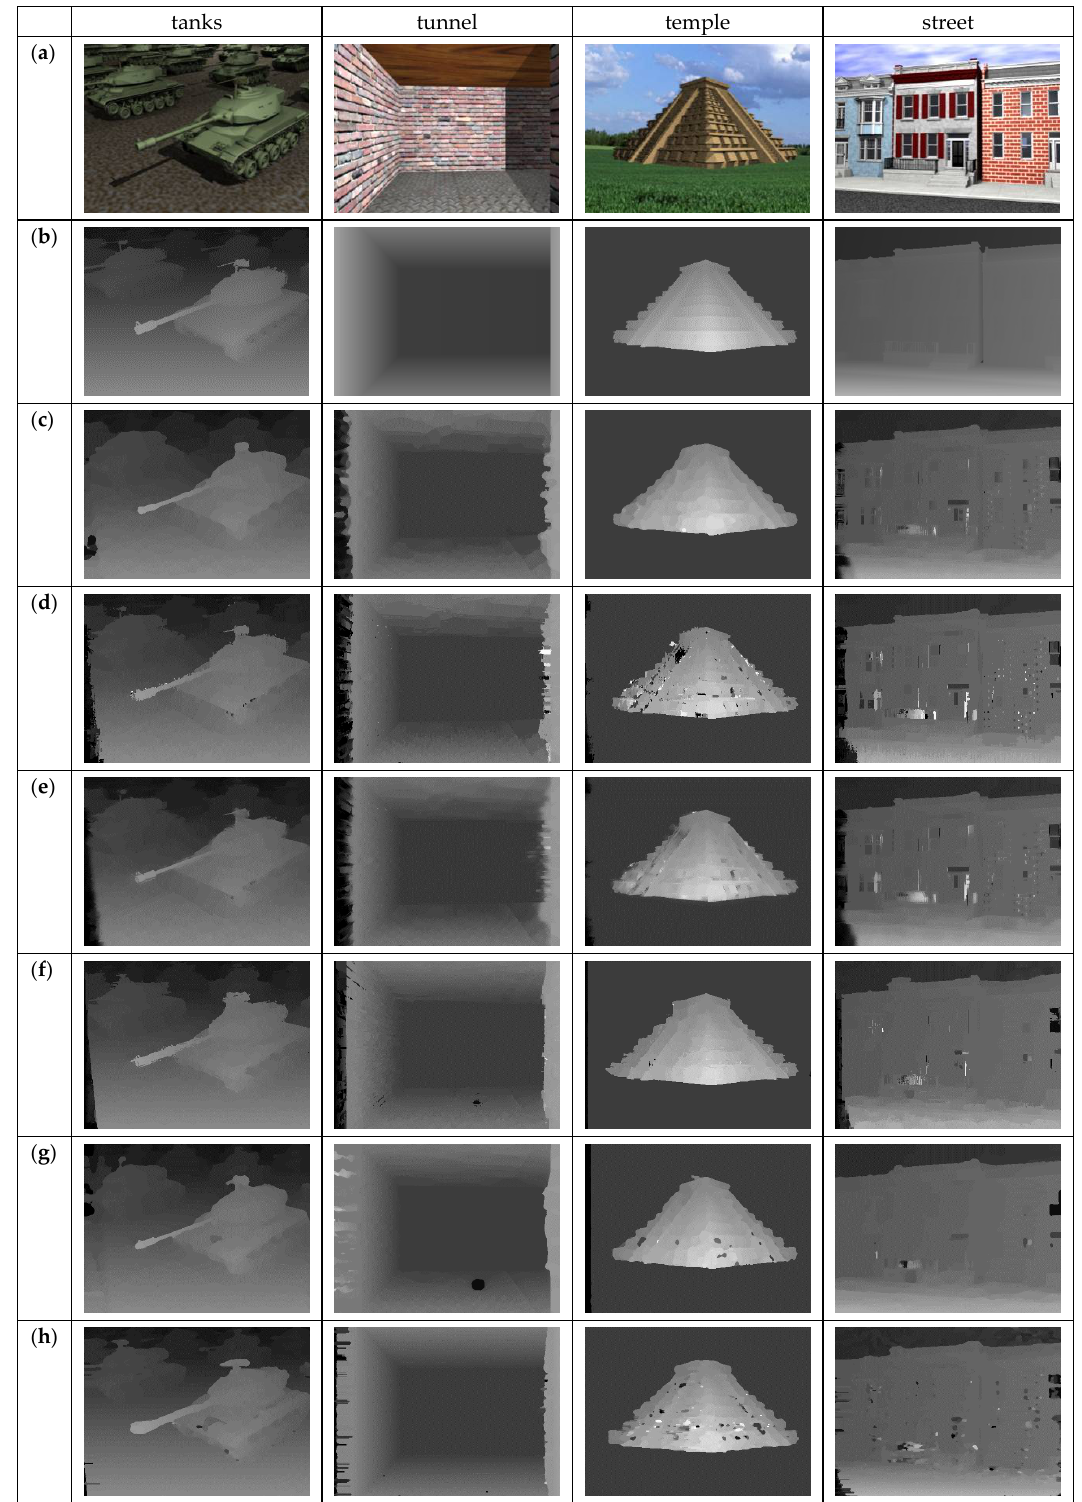
Figure 11. Refined results for 12th frame [9]: ( a ) original image; ( b ) ground truth; ( c ) our proposed method; ( d ) method of Zhang et al. [5]; ( e ) method of Lin et al. [3]; ( f ) method of Jung et al. [12]; ( g ) method of Zhan et al. [14]; and ( h ) method of Yang et al. [7].